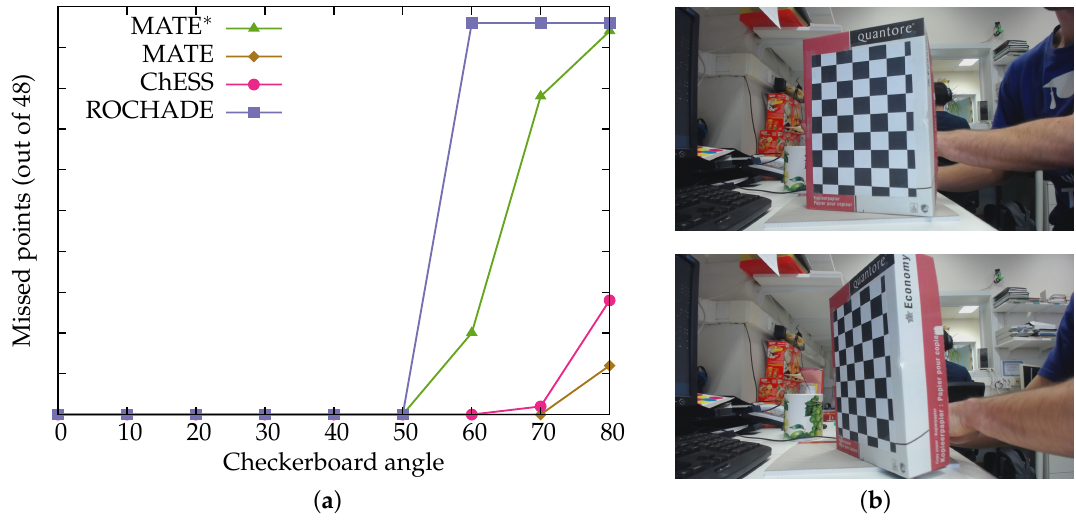
Figure 8. The results from the ’angle’ dataset. ( a ) the checkerboard angle against the number of missed points; ( b ) example images (20 and 60 degrees,